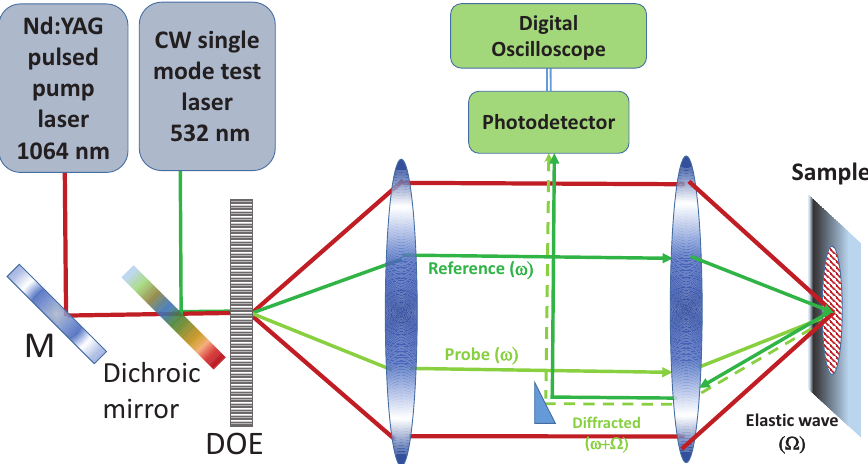
Figure 3. Optical set-up and laser system for TGM (transient grating method) experiment in reflection geometry. Two convergent lens; M: mirror; DOE: diffractive optical